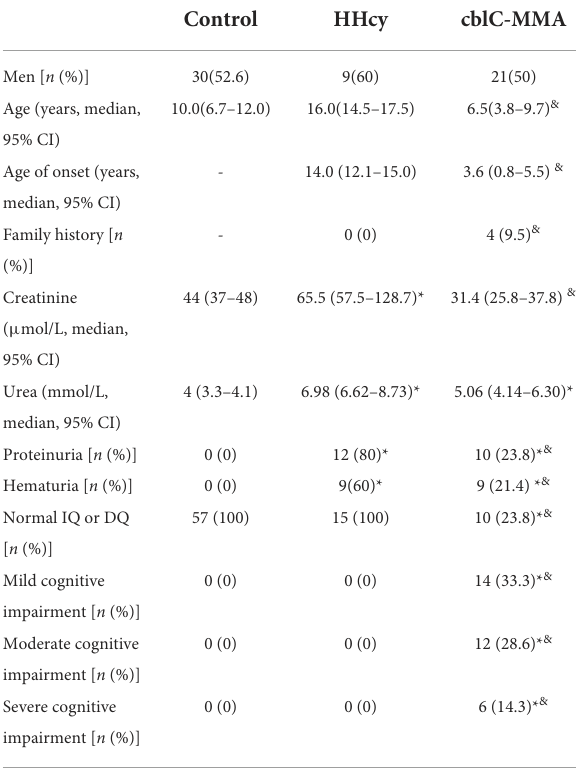
TABLE 1 Clinical and biochemical data of study